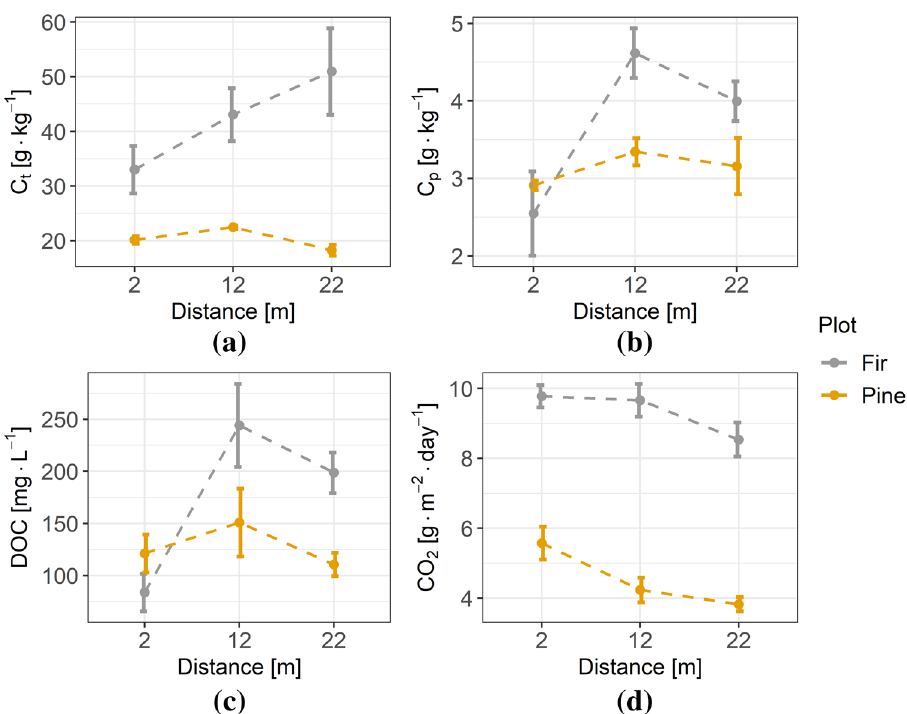
Figure 2. Total carbon (C t ) ( a ), pyrophosphate extractable carbon (C p ) ( b ), dissolved organic carbon (DOC) ( c ), and soil CO 2 respiration ( d ) plotted against the distance from the forest edge. The circle represents the mean; the whiskers indicate the standard error.